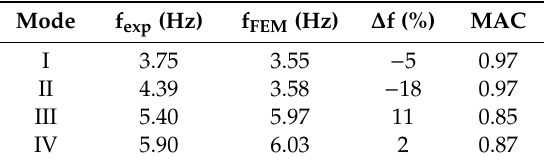
Table 4. Ufita bridge: comparison between numerical and experimental